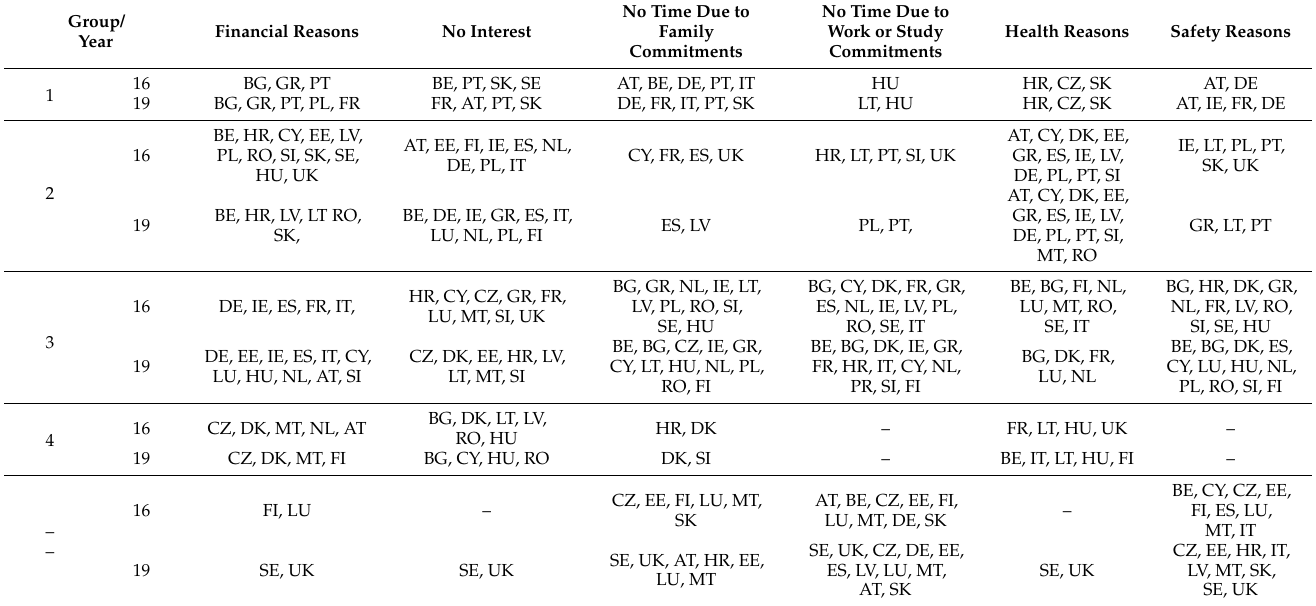
Table 2. Importance of reasons for the non-participation of Europeans aged 65 and over in tourism in 2016 (16) and 2019